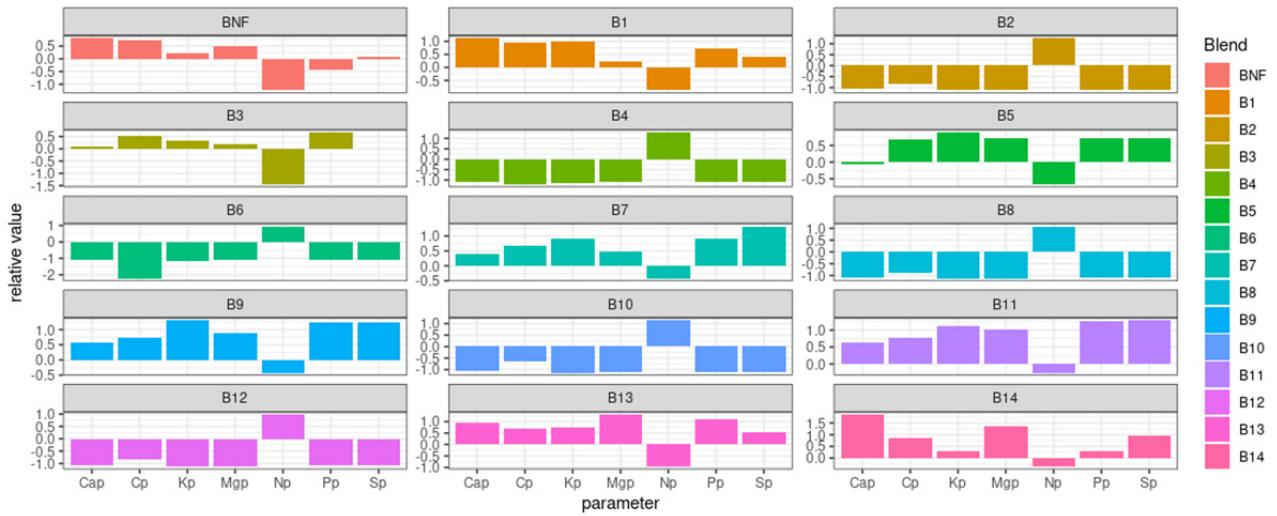
Figure 6. Relative nutrient concentration in the plant shoots tissue at the end of the experiment under the different blends (B = blend, BNF = no fertiliser).